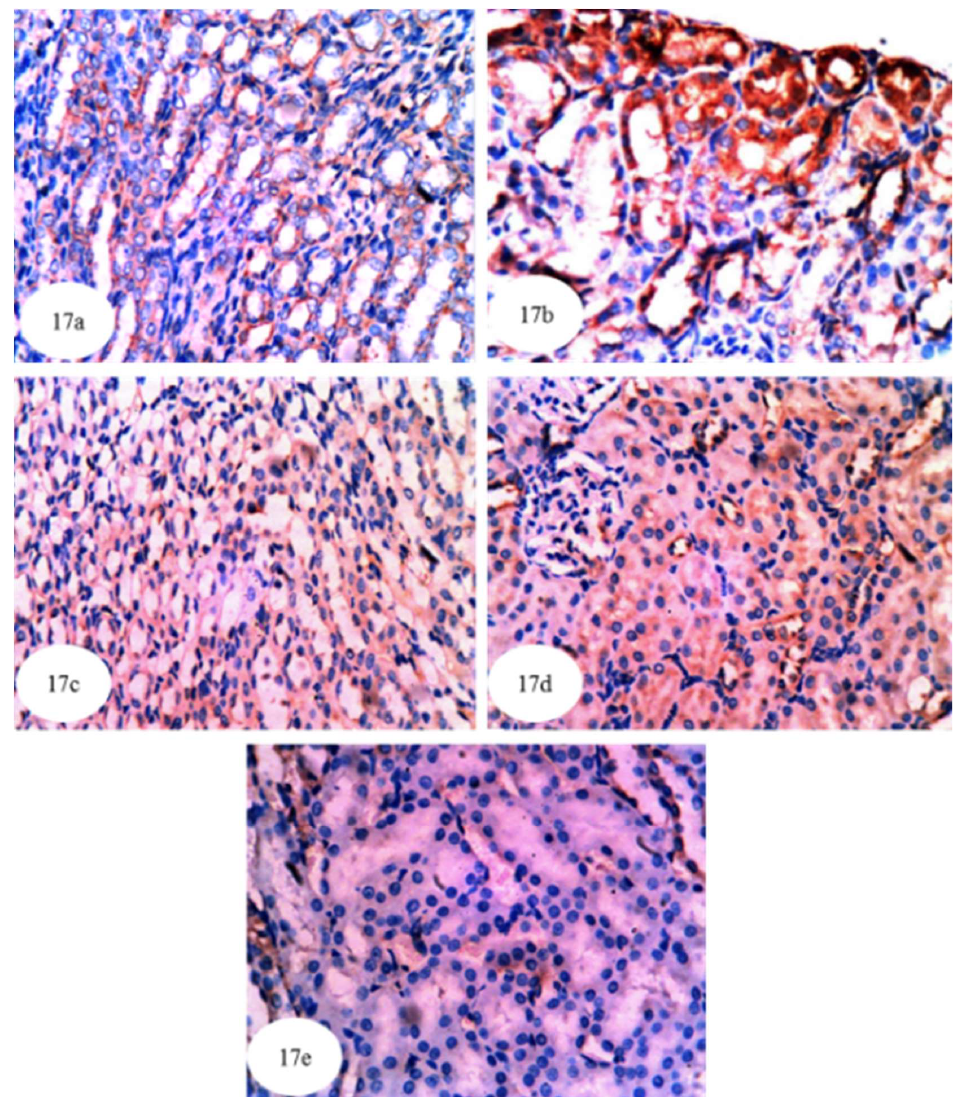
Figure 17. Photomicrographs ( a – e ) of immunohistochemically stained kidney sections. Images showed the higher amount of NF-κB (yellowish brown color) in cytoplasm and nuclei of ethylene glycol control group ( b ) (×384) as compared with normal control rats ( a ) (×384). The treatment of ethylene glycol administered rats with P. ostreatus ( c ) (×384) and A. bisporus ( d ) (×384) infusions and carvedilol ( e ) (×384) markedly decreased the dark brownish color of NF-κB.